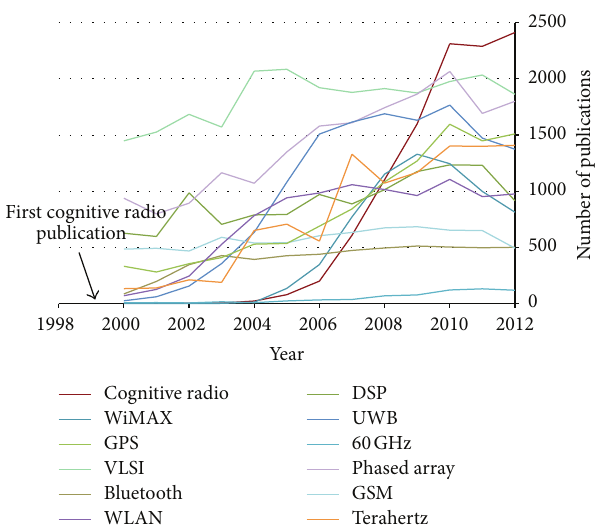
Figure 1: Number of publications in different research areas in the last